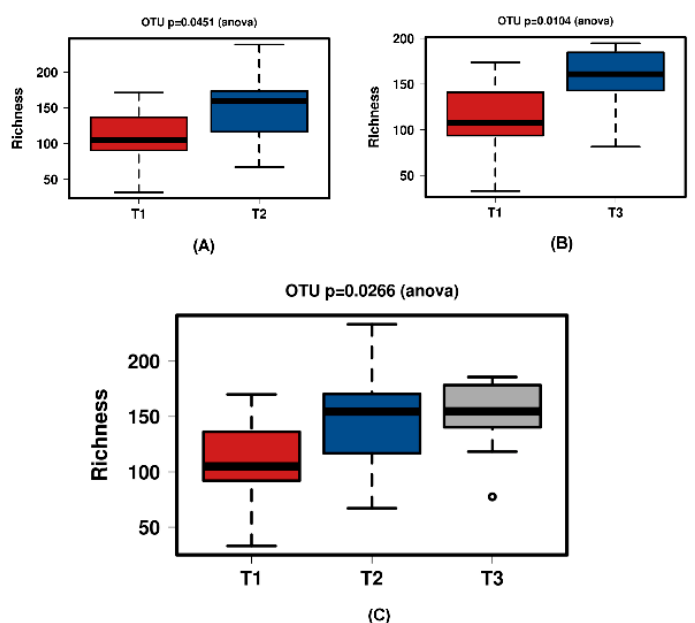
Figure 8. Richness for the JooMo group samples. ( A ) shows T1 and T2 with a significant increase over time. Samples normalised to a read depth of 2364 sequences; ( B ) shows T1 and T3 with a significant increase over time. Samples normalised to a read depth of 2366 sequences; ( C ) shows T1, T2 and T3 with a non-significant increase over time. Samples normalised to a read depth of 2361 sequences.